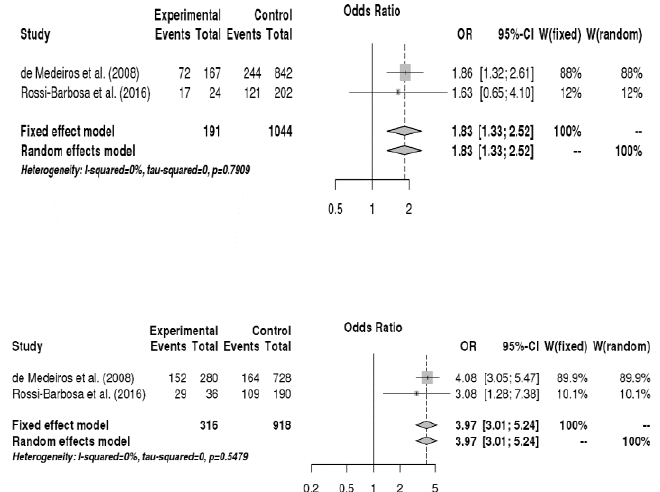
Figure 5. Forest plot showing the relationship between vocal disorders and making a loud voice, the number of classes per week, noise generated out of the school, and leave from work due to voice disorders (from up to down in sequence).